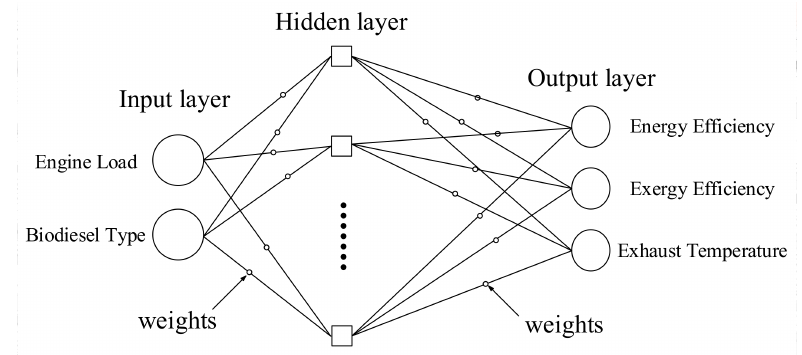
Figure 2. The architecture of the ANN network.